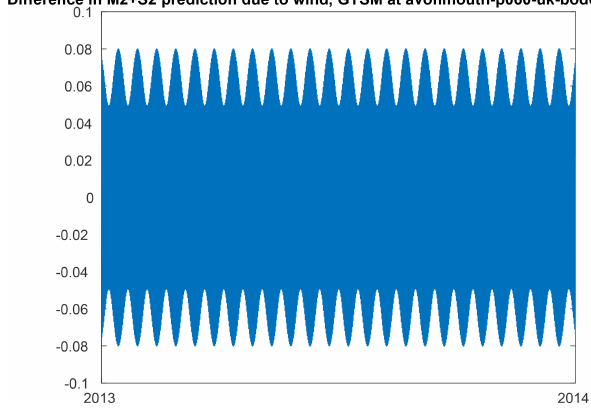
Figure 2. Fortnightly cycle of prediction change (metres) due to small changes in constituents M 2 + S 2 alone based on Avonmouth. S 2 amplitude change 3.5cm, phase change 3.5 ◦ , M 2 amplitude change 1cm, phase change 0.2 ◦